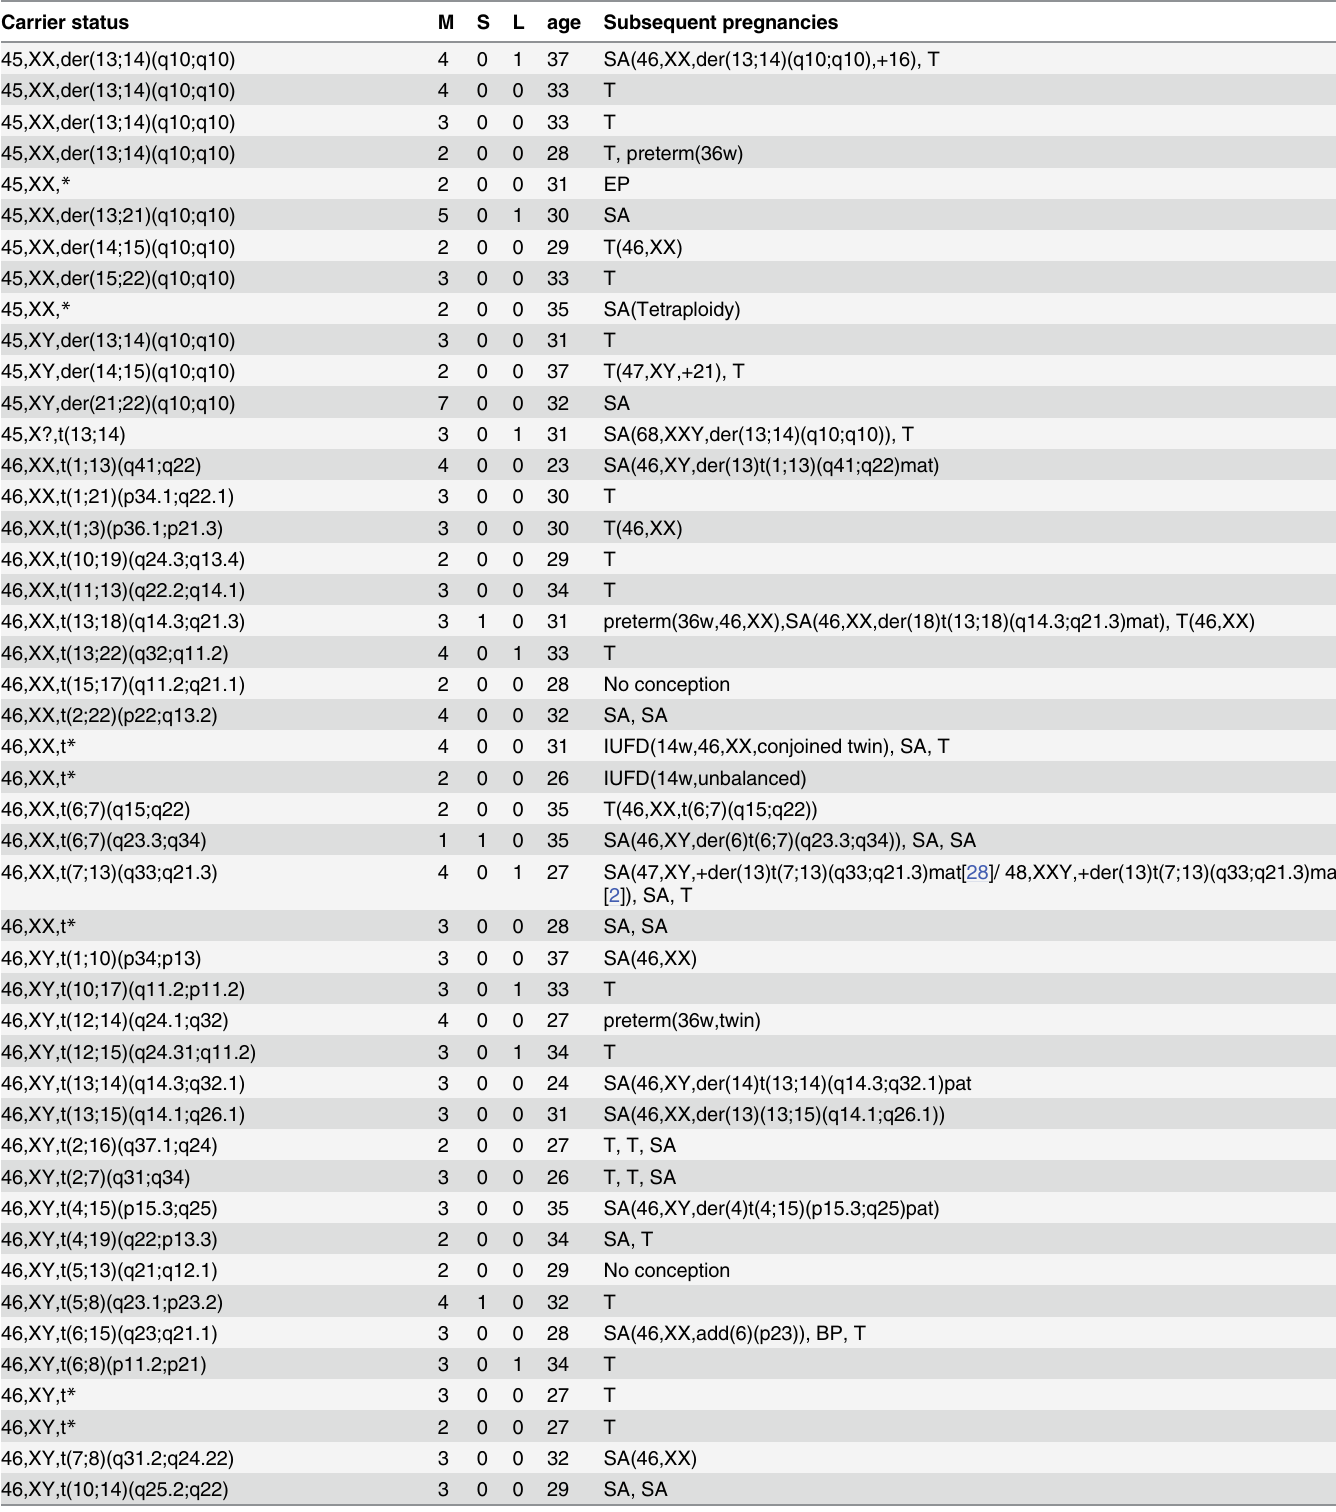
Table 1. Carrier status of the 52 patients who conceived